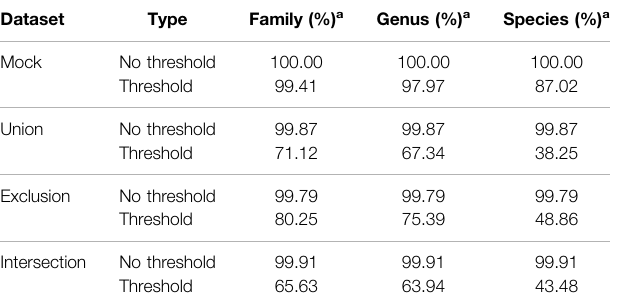
TABLE 4 | The comparison of assignment depth using the taxonomy-based ITGDB with and without application of a con fi dence threshold. Dataset